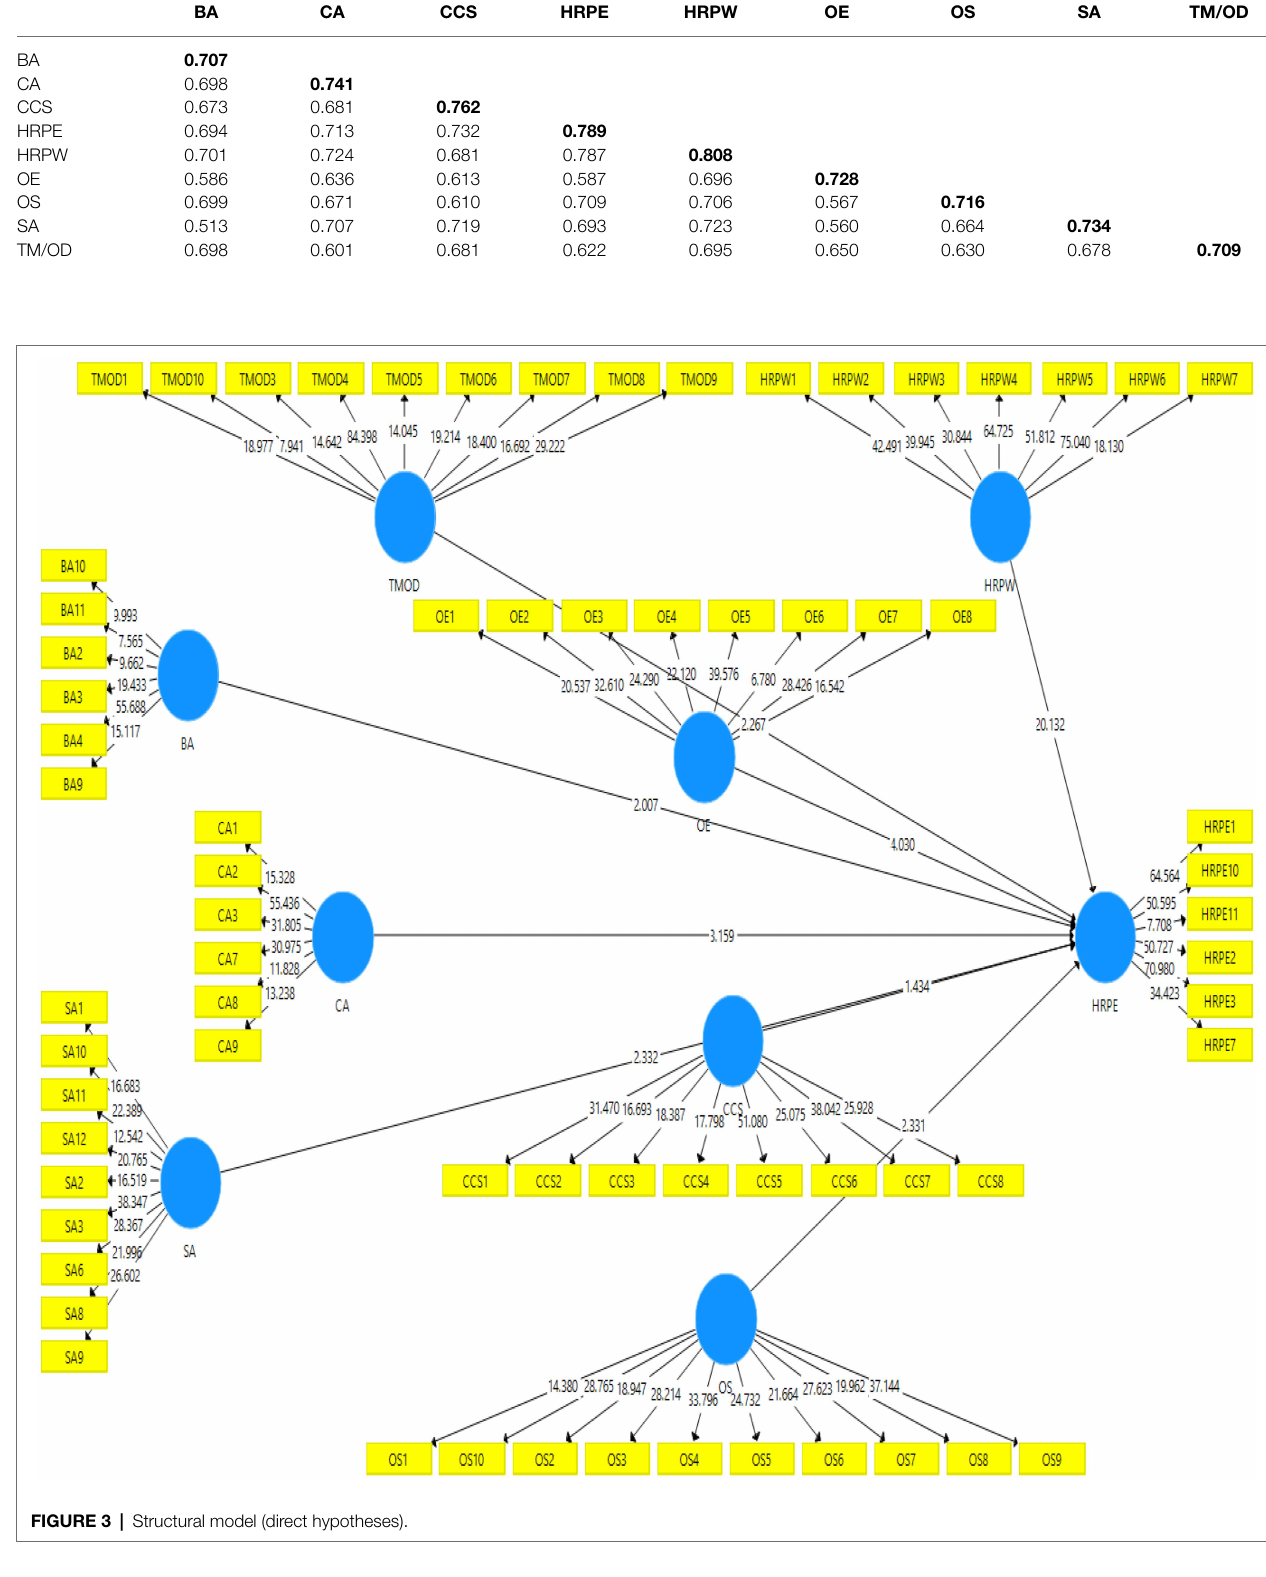
FIGURE 3 | Structural model (direct hypotheses).